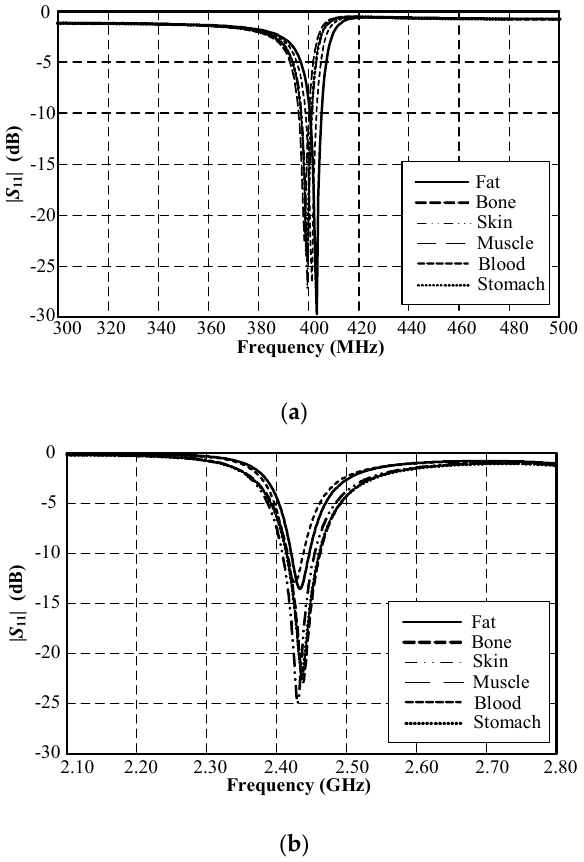
Figure 8. Simulated | S 11 | of the MICS/ISM meander-line microstrip antenna encapsulated in a glass pod inside a solid spherical model with a diameter of 50 mm: ( a ) MICS and ( b ) ISM bands.